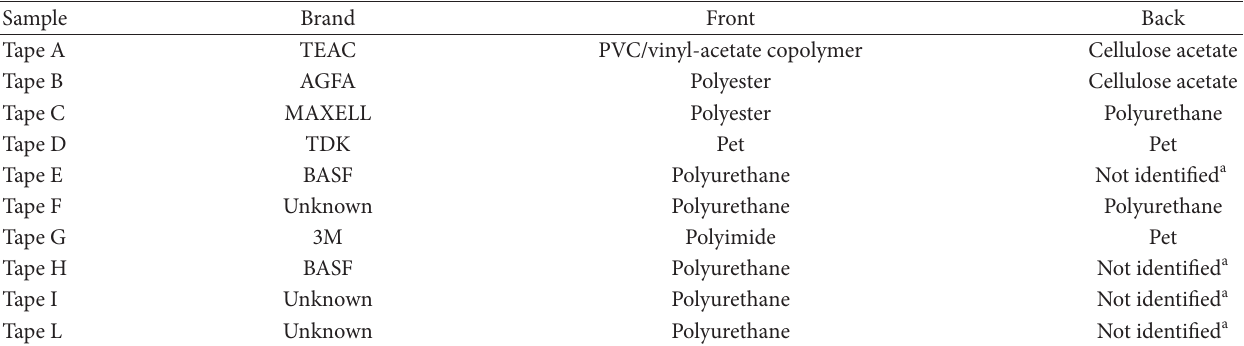
Table 1: The Table summarizes the results of the FTIR spectroscopic analysis in ATR. In the first column there are the tape samples. For each of them, the material composing the base (column titled Back) and the side with the magnetic particles (column titled Front) is indicated. Tapes are identified only by the brand, because the model was unknown for all but one (Tape E: BASF SPR 50 LHL). Sample Brand Front Back Tape A TEAC PVC/vinyl-acetate copolymer Cellulose acetate Tape B AGFA Polyester Cellulose acetate Tape C MAXELL Polyester Polyurethane Tape D TDK Pet Tape E BASF Polyurethane Not identified a Tape F Unknown Polyurethane Polyurethane Polyimide Pet Tape H BASF Polyurethane Tape I Unknown Polyurethane Tape L